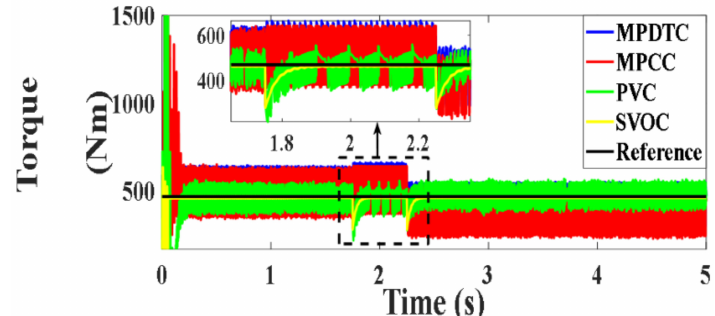
Figure 188. Comparison between torques of four techniques (Nm).